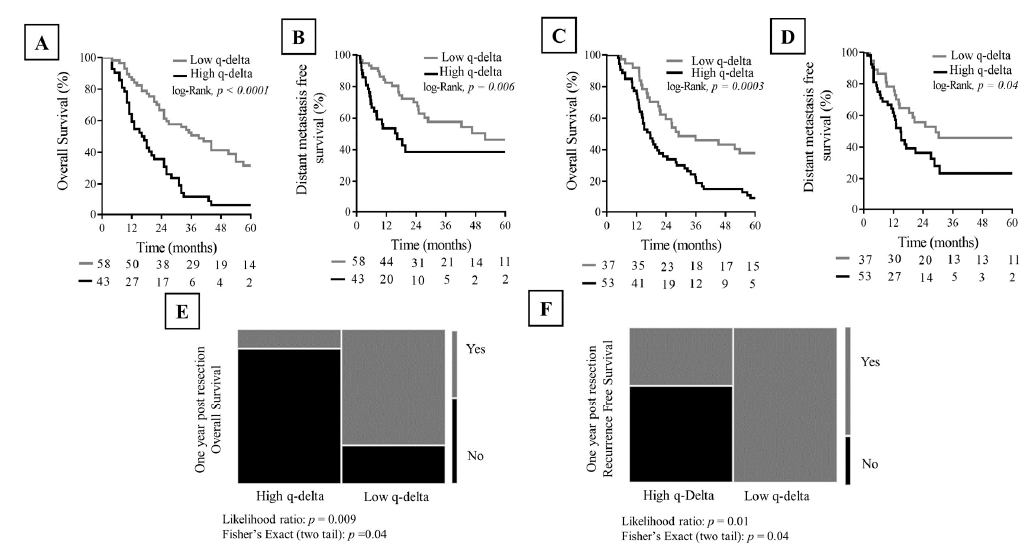
Figure 3. Kaplan Meier analysis shows model-identified q-delta association with the clinical outcome in the training set D1 ( A , B ) and the internal validation set ( C , D ). Contingency plot shows the association between the q-delta and clinical outcome in the external validation set ( E , F ). Table 3. Univariate and multivariate analyses of patients who underwent upfront surgery for resectable PDAC (D1).